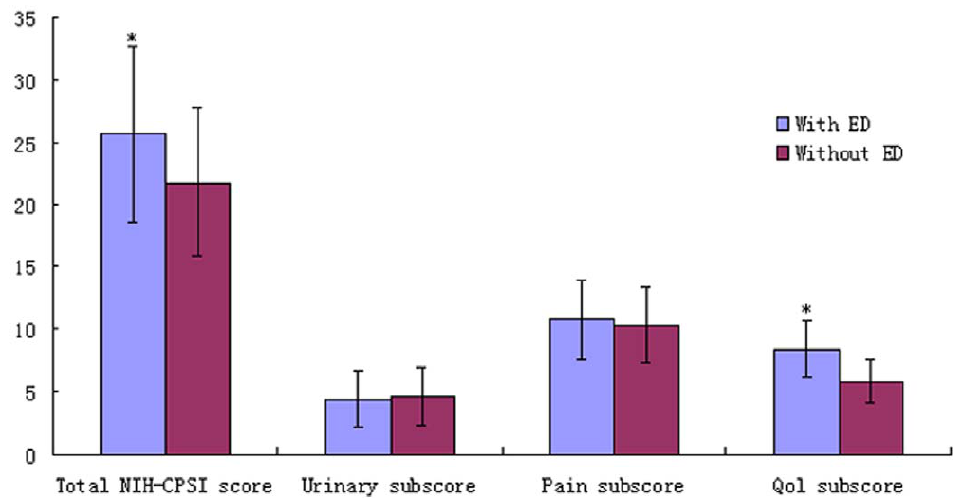
Figure 4. Correlation between NIH-CPSI symptom scores and ED. Total NIH-CPSI symptom score and its urinary, pain and QoL subscores were compared between CP/CPPS patients with and without ED. The presence of ED had a significant effect on the total NIH-CPSI score and its QoL subscore, but not on its urinary and pain subscores (*P , 0.05).